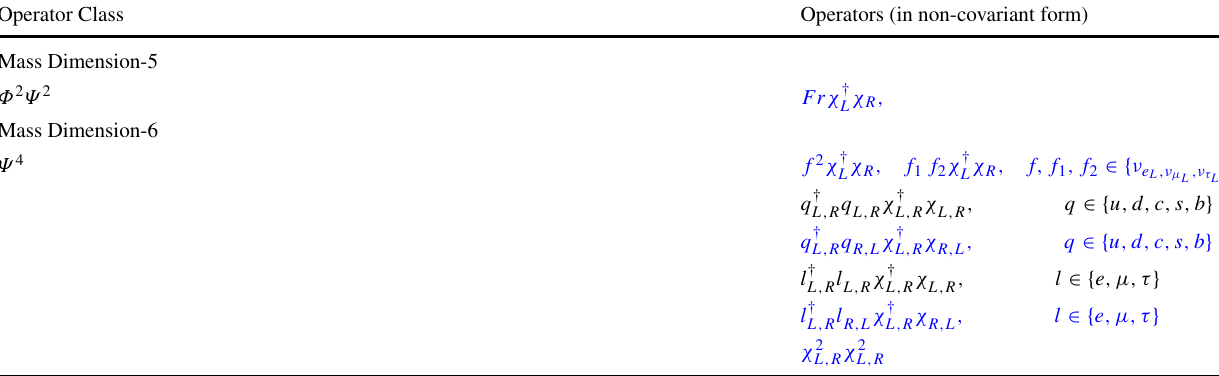
Table 45 Model 2( χ L , R ): Operators of mass dimensions-5 and -6 excluding pure SM